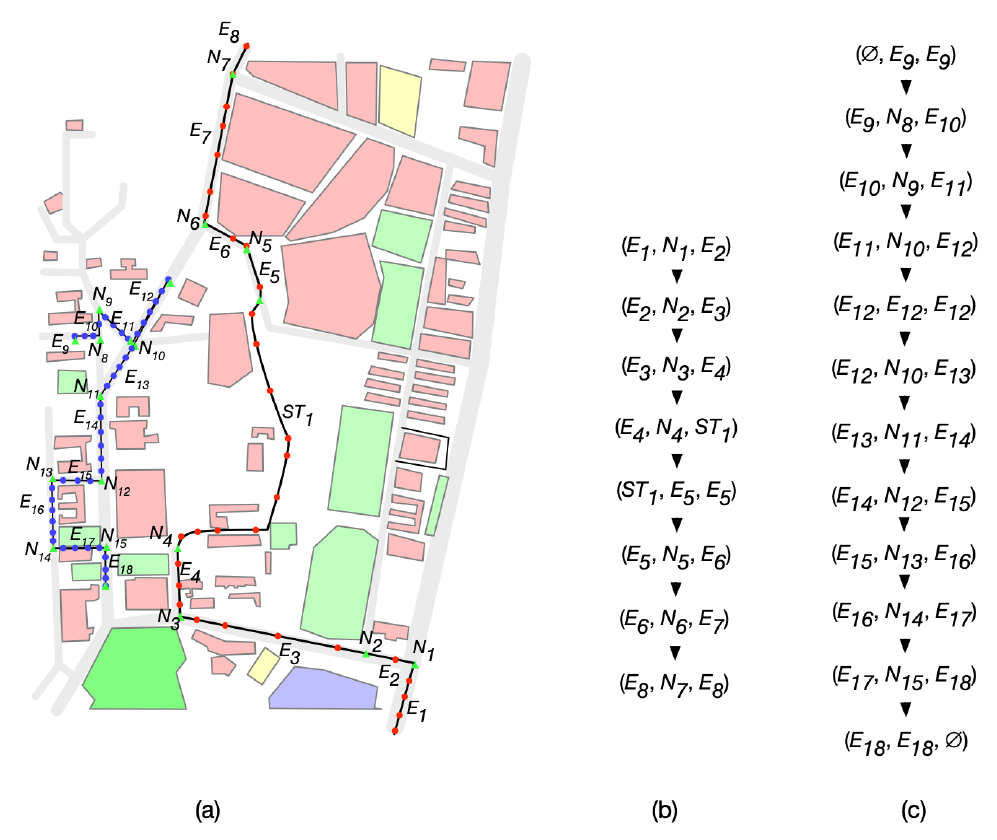
Figure 5. Two real trajectories within the road network. ( a ) Images of the two trajectory; ( b ) intersections sequences of the student’s trajectory; ( c ) intersections sequences of the teacher’s